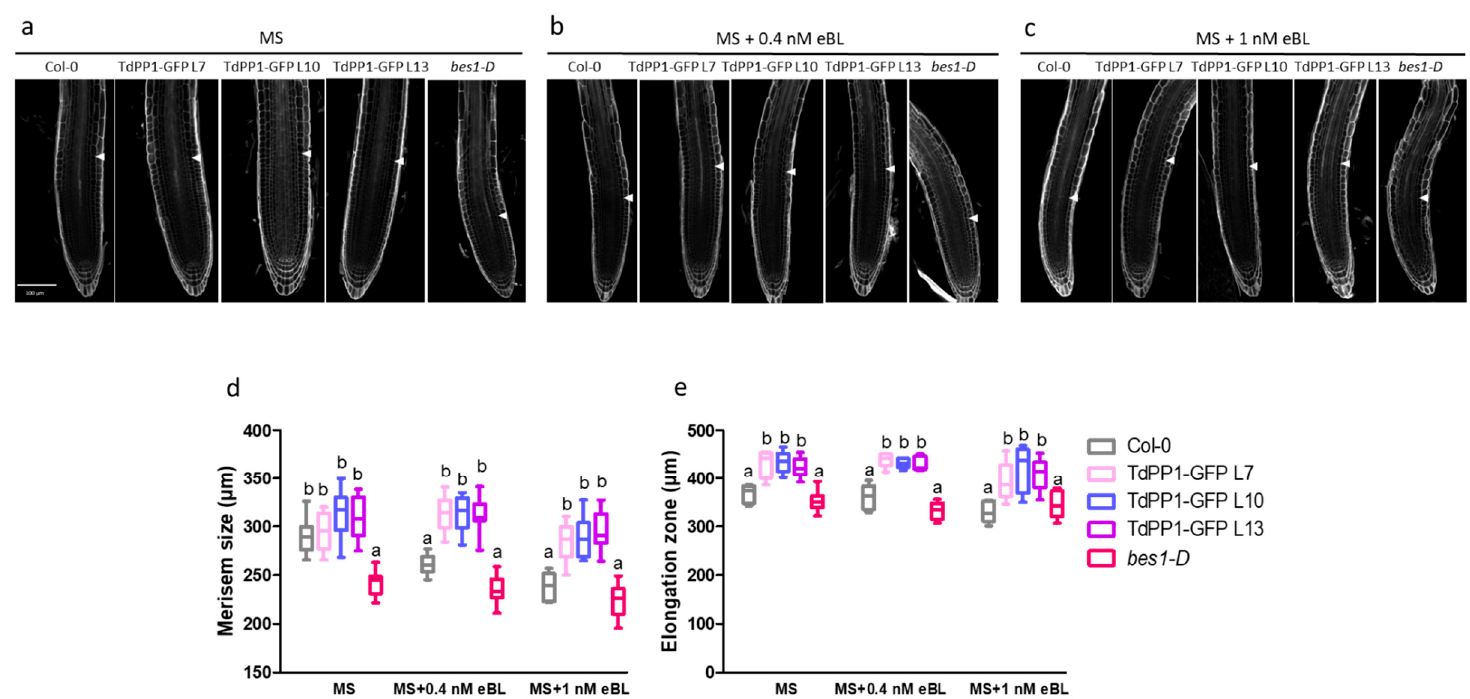
Figure 2. Roots of TdPP1 expressing lines are hyposensitive to exogenous eBL. ( a – c ) Effect of exogenously applied eBL on meristem size. Confocal images of 5-day-old WT, TdPP1-GFP OE lines and bes1-D grown under control conditions (MS; a ), or treated with 0.4 nM ( b ) or 1 nM eBL ( c ). Seedlings were treated with ClearSee, stained with calcofluor-white. Arrows indicate boundary between the proximal meristem and the elongation zone of the root. Scale bars: 100 µm. ( d ) Meristem size of WT, TdPP1-GFP transgenics and bes1-D exposed or not to eBL. Meristematic zone size was defined as the region of isodiametric cells from the QC up to the cell that was twice the length of the immediately preceding cell. Letters indicate statistically significant differences between WT vs TdPP1-GFP OE (L7, L10 and L13) and bes1-D as determined by one-way ANOVA followed by Tukey’s multiple comparison test ( p -value < 0.05). Data represent mean values of 15 measurements and error bars are SD. ( e ) Size of elongation zones of WT, TdPP1-GFP transgenics and bes1-D exposed or not to eBL. Elongation zone was considered as the region going from the end of the meristematic zone to the beginning of differentiation zone (emergence of first root hair). Letters indicate statistically significant differences between WT vs TdPP1-GFP OE (L7, L10 and L13) and bes1-D as determined by one-way ANOVA followed by Tukey’s multiple comparison test ( p -value < 0.05). Data represent mean values of 15 measurements and error bars are SD.